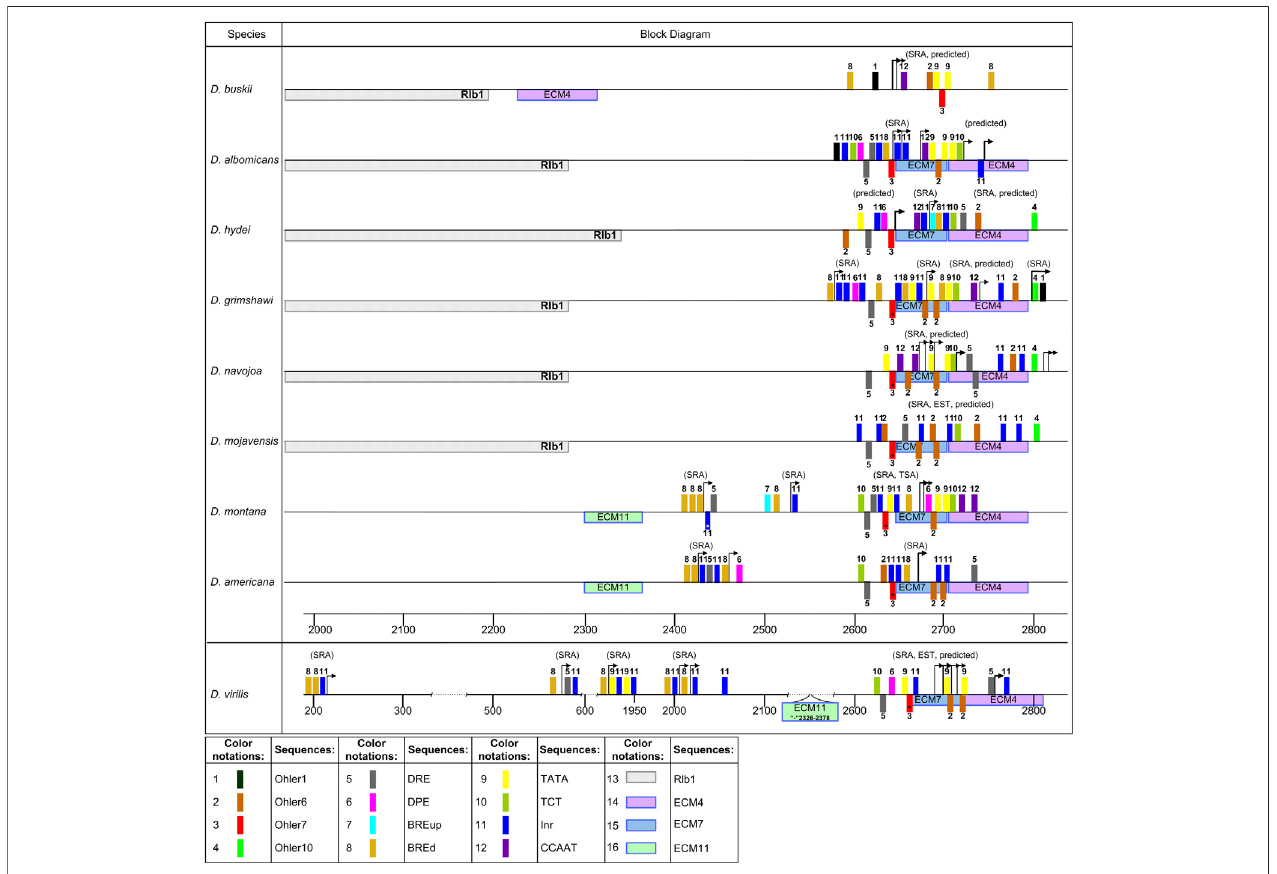
FIGURE 9 | Distribution of the elements in the promoter region in the subgenus Drosophila . Designations as in Figure 7 .